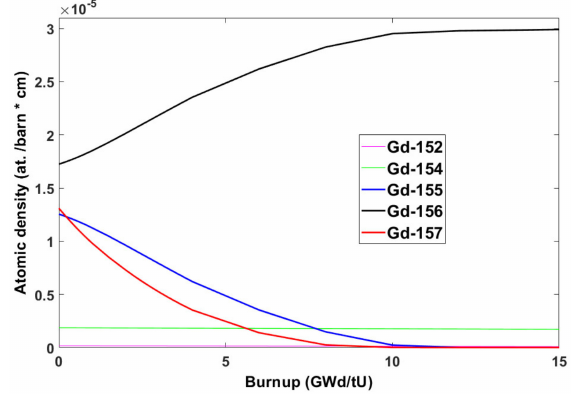
Figure 6. Simulated Gd atomic density vs. burnup for an EPR single assembly (2.1 wt% + 8 Gd, burning 10 rings) using